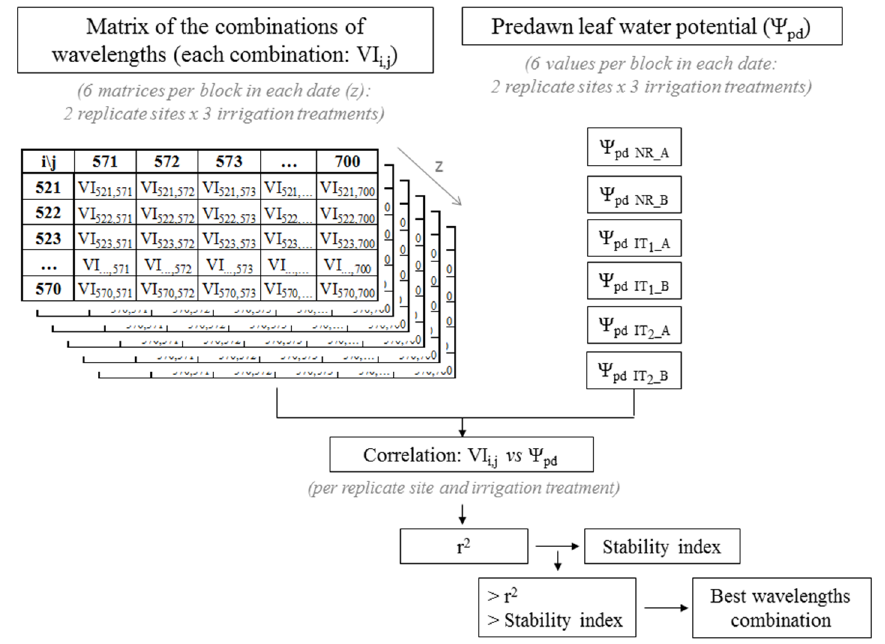
Figure 2. Scheme of the procedure for selecting the best wavelengths for computation of a vegetation index using a wavelengths interval of 1 nm. The scheme refers to a vegetation index combining the wavelengths of the green (i) and red (j) regions of the electromagnetic